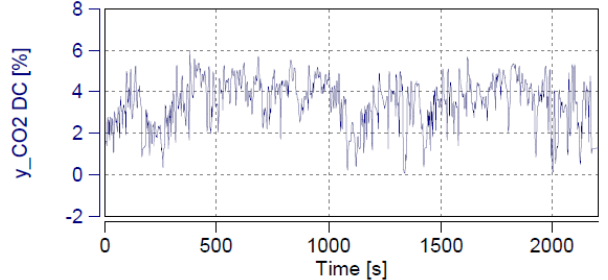
Fig. 5. Carbon dioxide concentration during the test In the case of the course of carbon dioxide emission, a clear correlation was observed with the vehicle speed pro- file during the test. At the same time, it was discovered that the oxygen concentration curve is an inverse of the carbon dioxide curve, which was expected.